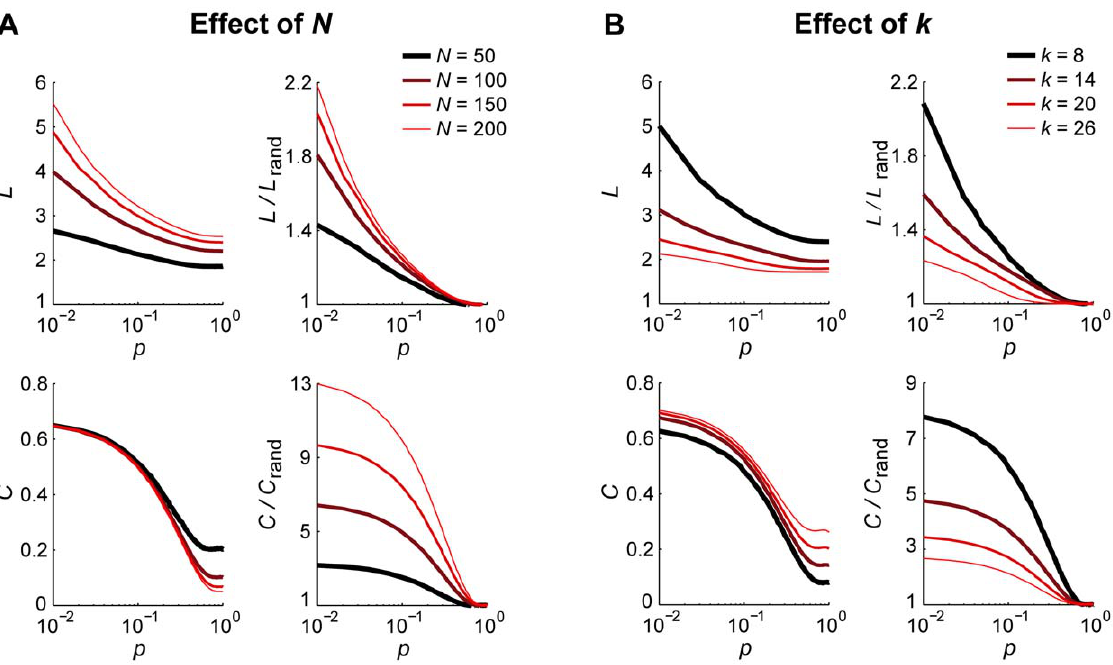
Figure 4. The sensitivity of small-world networks to size and average degree changes depends on rewiring probability. The dependence for normalized path length and clustering coefficient ( L / L rand and C / C rand with Erdo¨s-Re´nyi random networks) decreases with rewiring probability p (stronger resemblance to random networks). A : Effects of changes in the number of nodes ( N ) while keeping the average degree constant ( k =10). B : Effects of changes in the average degree ( k ) while keeping the number of nodes constant ( N =100).